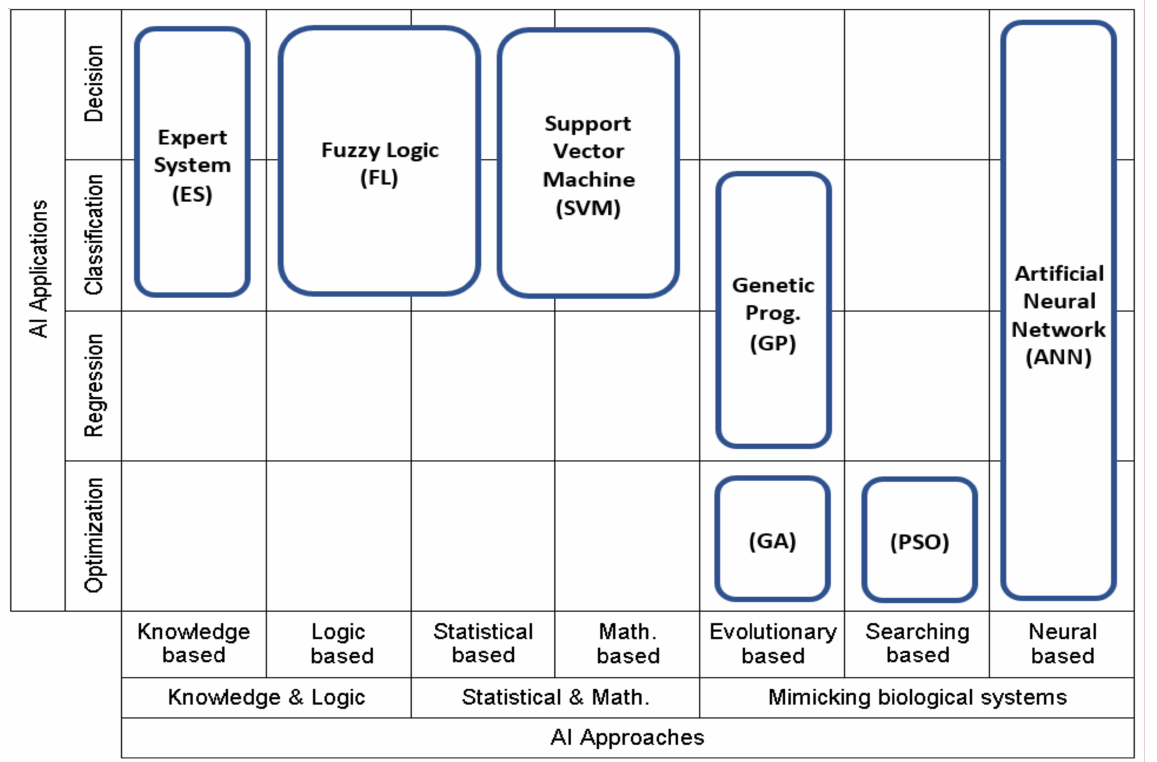
Figure 2. (Application–Approach) mapping for the considered (AI) techniques.